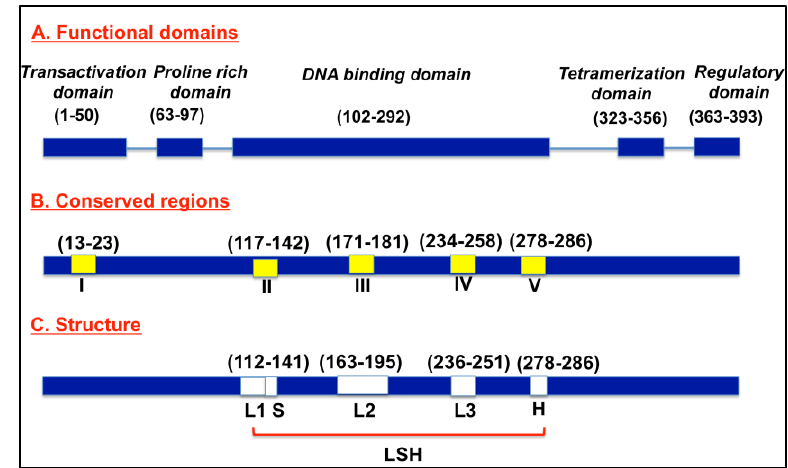
Figure 1. Schematic of p53 protein structure.